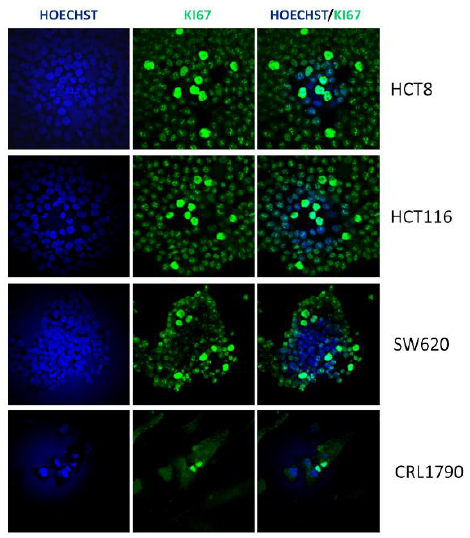
Figure 3. Representative double-labeled immunofluorescence images for Ki67 (green) and Hoechst (blue) in HCT8, HCT116, and SW620 CRC cells, and embryo colonic CLR1790 cells after 72 h of culture.